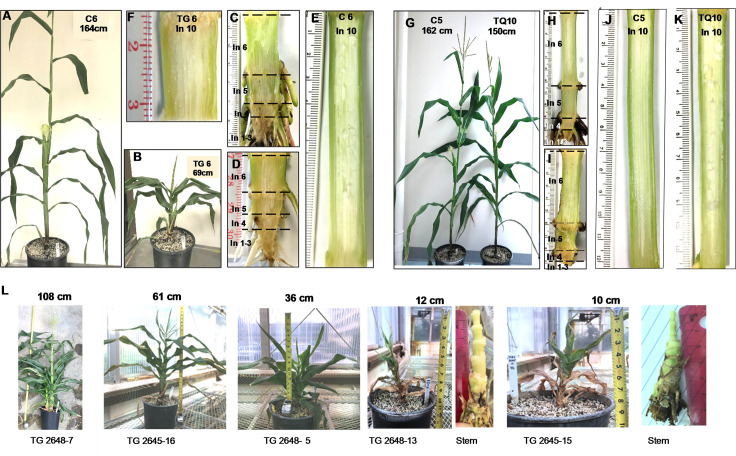
Plant morphological phenotypes of FAEA expressing TG and TQ plants at the VT stage of development.Maize plants at VT stage expressing apoplast FAEA, either constitutive (TG plants) or senescence induced (TQ plants), compared with control plants. C6 control (A) and TG6 stature mutant (B); Internode phenotypes (C-F). Internodes1-6 (C) and 10 I of C6; and Internodes1-6 (D) and 10 (F) of TG6. TQ10 plants and C5 control (G). Internode phenotypes (H-K). Internodes1-6 (H) and 10 (J) of C5, and Internodes1-6 (I) and 10 of TQ10 (K). Five examples of the range of TG stature mutants generated by constitutive apoplastic FAEA expression (L). All plants were grown under glasshouse conditions.